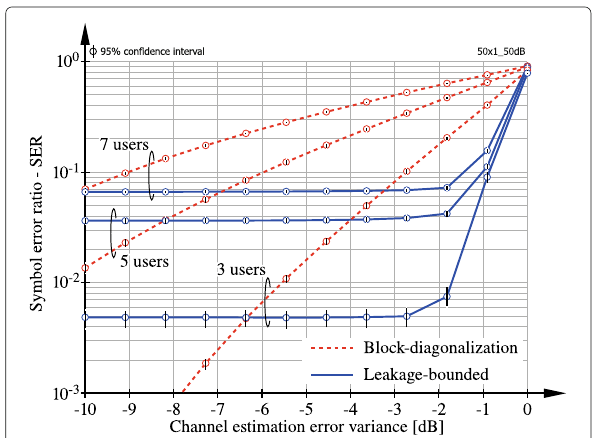
Fig. 6 Sensitivity of the SER achieved with BD precoding and leakage-bounded beamforming with respect to the channel estimation error for uncoded 16QAM transmission. Red: Block diagonalization; blue: